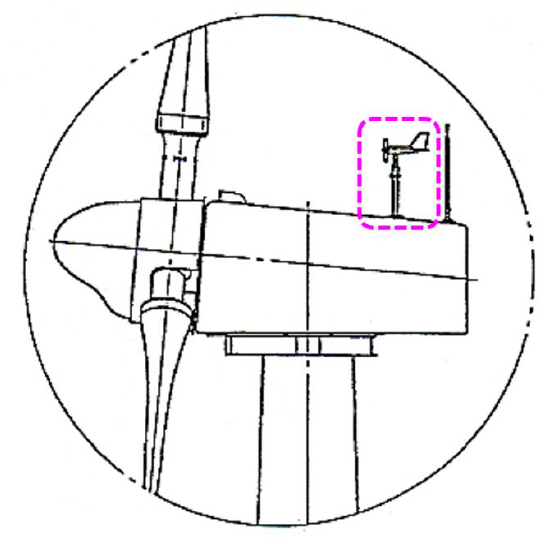
Figure 14. Propeller vane anemometer mounted on a wind turbine nacelle (indicated by the dotted line).